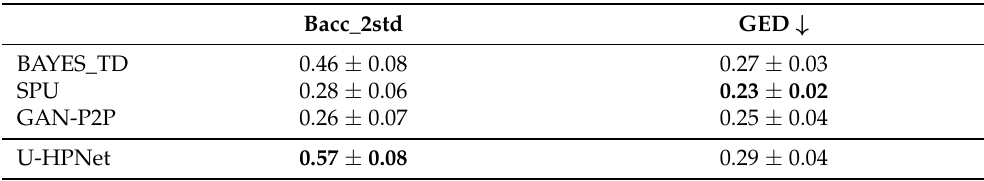
Table 6. Performance comparison with alternative networks for tumour growth using the estimated